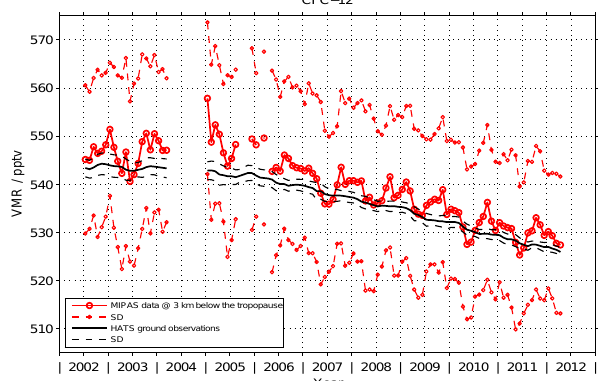
Figure 26. Comparison of MIPAS CFC-12 value estimates at 3km below the tropopause (red) and ground-based measurements col- lected by the HATS network (black).